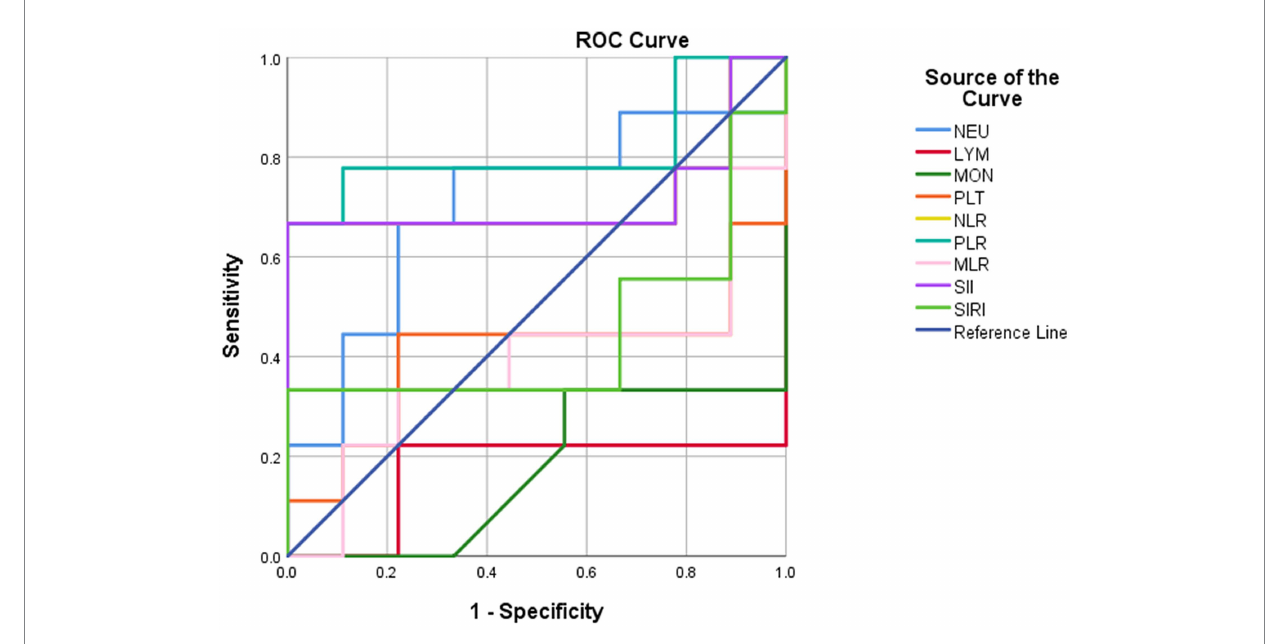
FIGURE 2 ROC curve analysis for distinguishing active phase from remission phase.